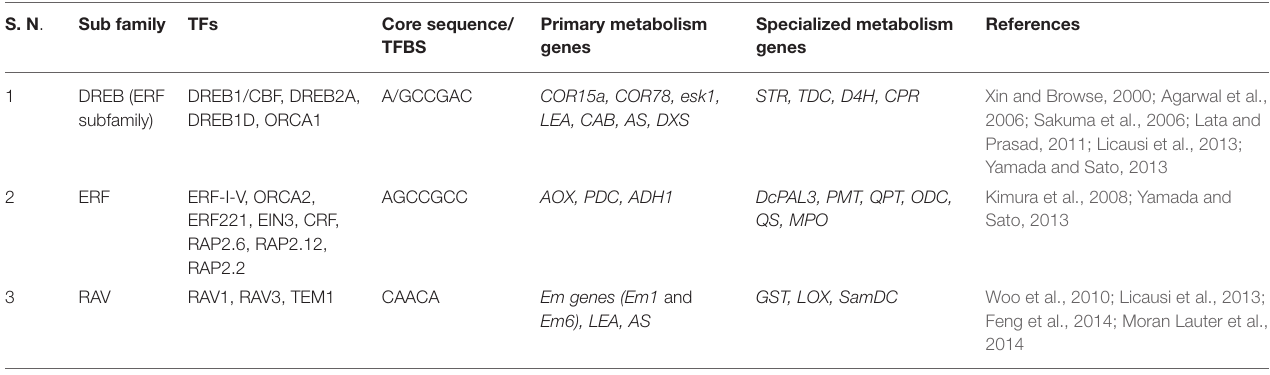
TABLE 4 | APETALA2 family TFs and their recognition sequences. S. N